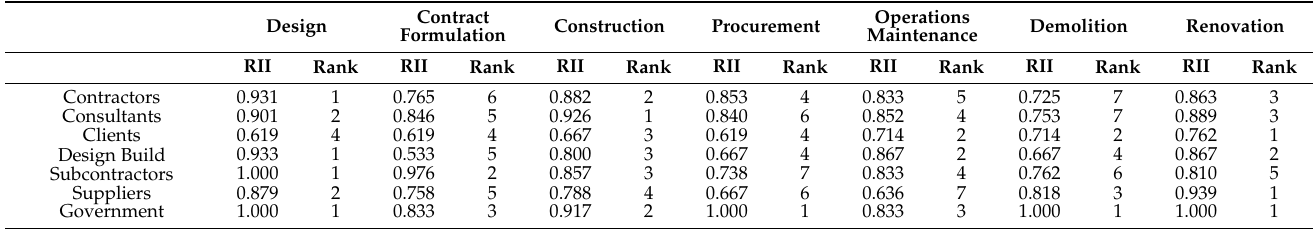
Table 14. Categorized RII ranking of the project phases, in terms of the project phase that the stakeholders mainly relate sustainability to, based on the respondents’ professional background.